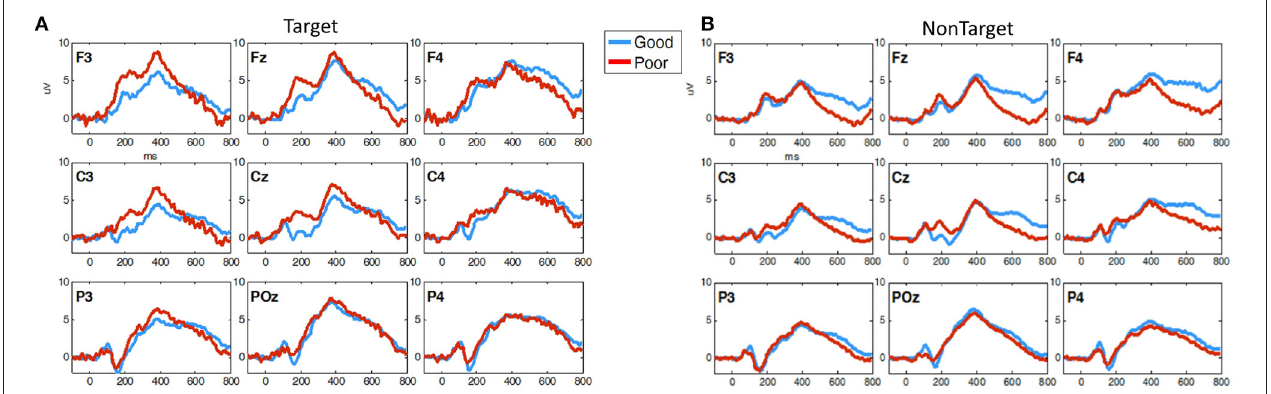
FIGURE 8 | Grand average ERP plots (averaged across participants) for (A) Non-Target and (B) Target trials during 3CVT task plotted for Good (blue)/Poor (red).